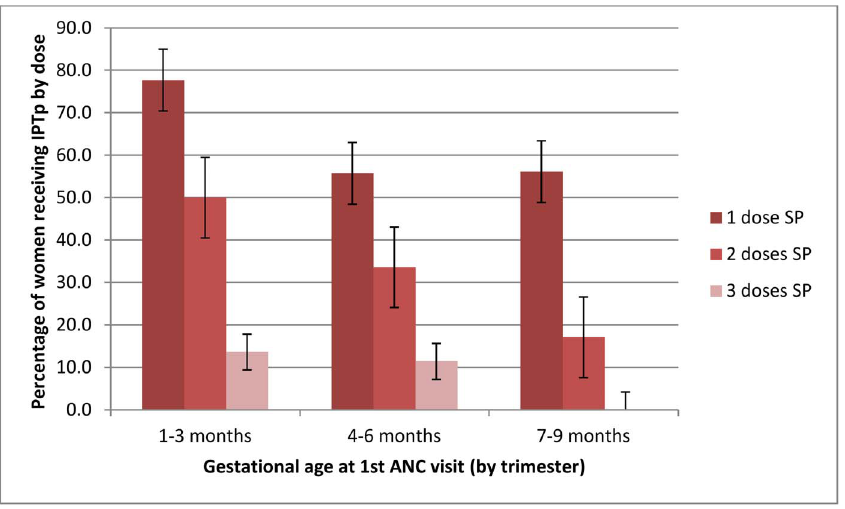
Figure 4. Number of SP doses received by trimester at 1 st ANC visit among recently pregnant women.